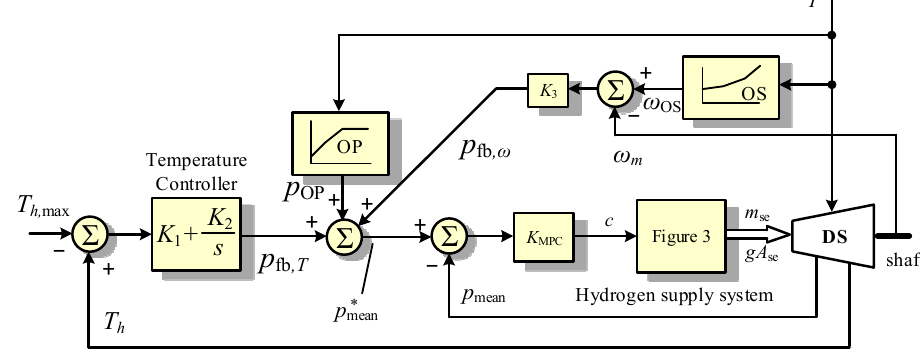
Figure 6. Schematic of the proposed prime mover control.